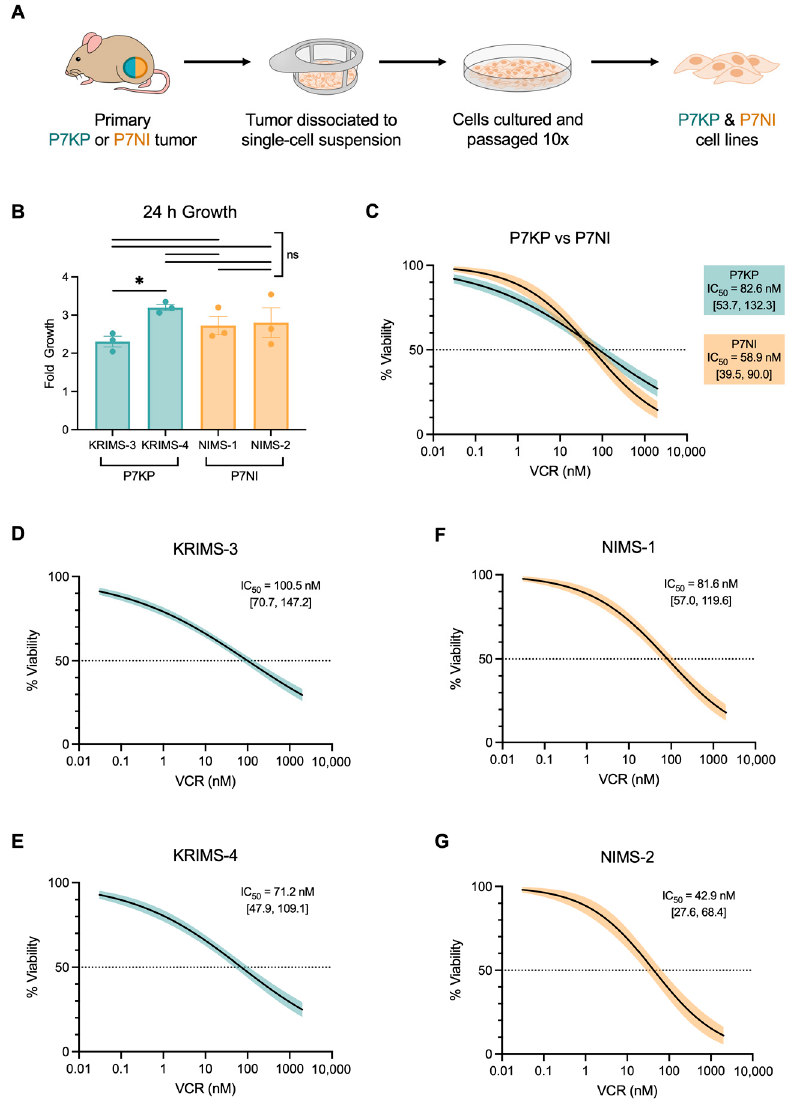
Figure 2. Development and characterization of P7KP and P7NI cell lines. ( A ) Terminal P7KP and P7NI tumors were enzymatically dissociated and cultured to develop cell lines. KRIMS (Kras Induced Murine Sarcoma) cells were derived from P7KP tumors and NIMS (Nf1 Induced Murine Sarcoma) cells were derived from P7NI tumors. ( B ) KRIMS and NIMS growth in vitro. Cells were seeded at equal densities and growth was assessed after 24 h. Data points represent independent experiments (n = 3). ( C – G ) Vincristine (VCR) dose-response curves. Cells were treated for 24 h. ( C ) Average dose-response curves by genotype. ( D – G ) VCR dose-response curves for individual cell lines. Data from 3–4 independent experiments included in each plot. Curves fitted using nonlinear regression, option “[inhibitor] vs. normalized response-variable slope” in GraphPad Prism (Version 9, Boston, MA, USA). Shaded areas represent 95% confidence intervals. Absolute IC 50 95% confidence intervals displayed in brackets. Welch’s ANOVA and Dunnett’s T3 multiple comparison test used to analyze B. * p < 0.05; ns = not significant.